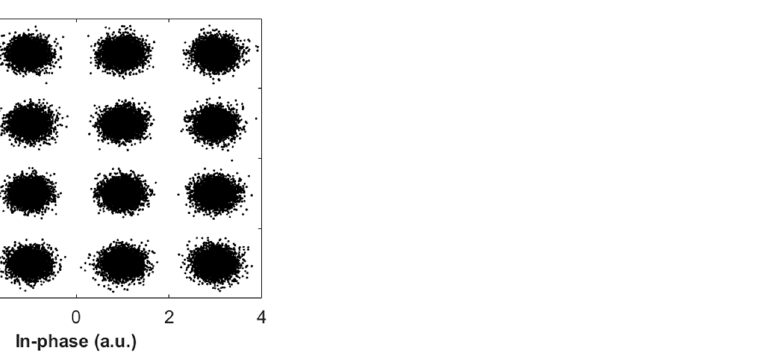
Figure 6. Example of received constellation diagram for QAM-16 in FSO coherent system (down- link), ( a ) before phase noise compensation, and ( b ) after phase noise compensation.